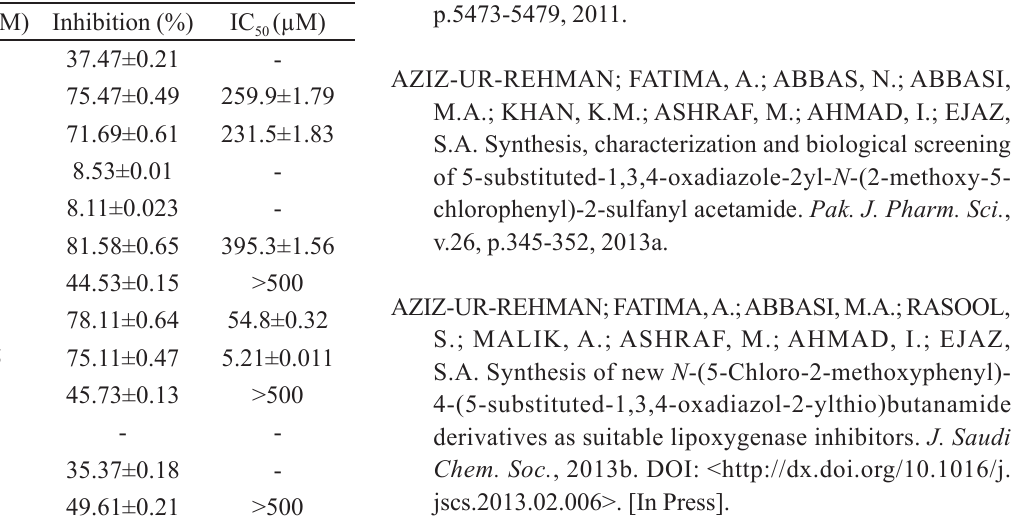
TABLE IV - The IC synthesized compounds